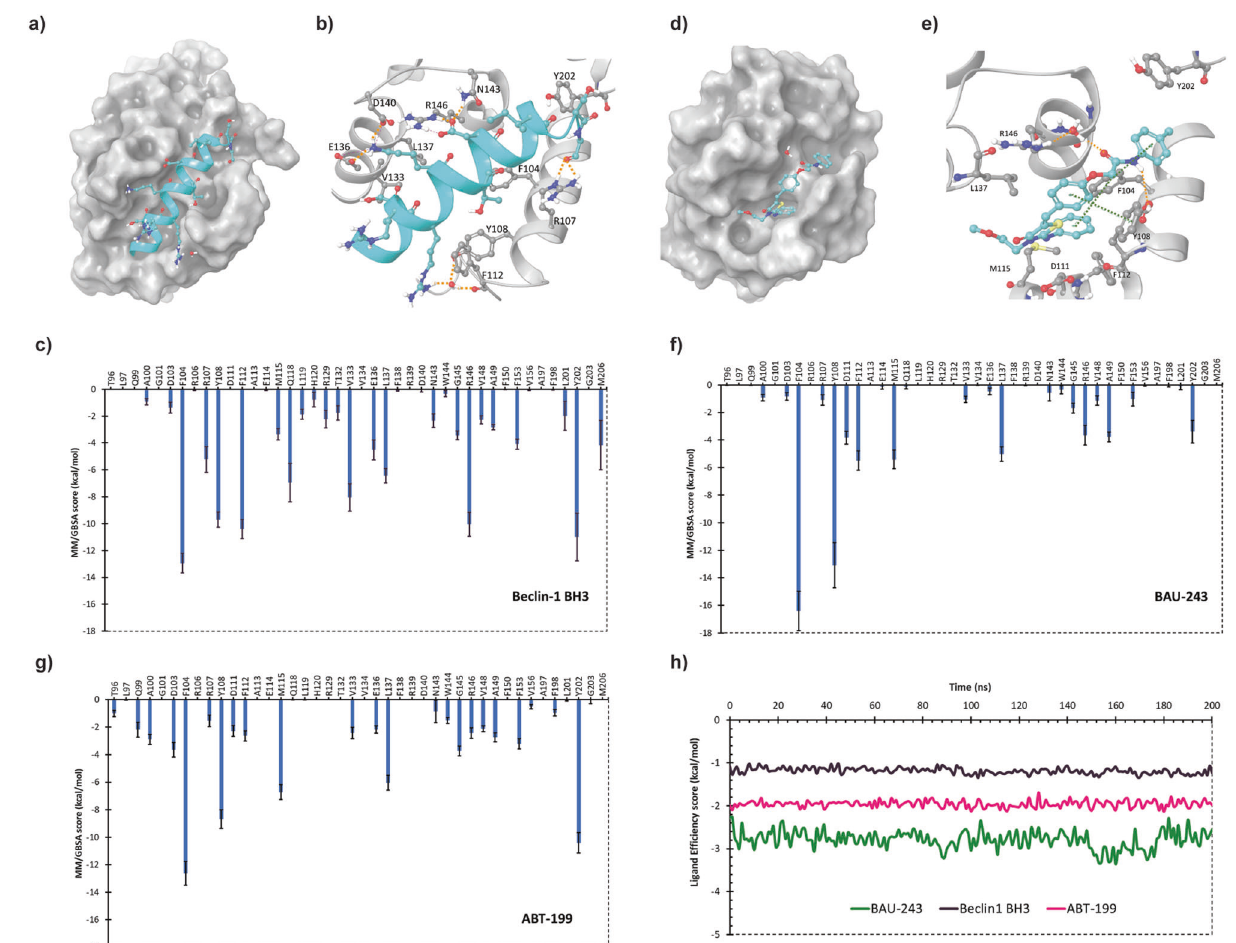
Fig. 6 BAU-243 interacted with BH3 binding domain of Bcl-2 protein. a Bcl-2 in complex with Beclin 1 BH3 domain with Bcl-2 represented as gray colored surface. Water molecules and residues of Beclin 1 BH3 are displayed with the ball and stick representation with C atoms colored in dark cyan, O atoms in red, N atoms in dark blue, and polar H atoms in white. Orange dashed lines indicate hydrogen bonds. b 3D representation of interactions between Beclin 1 BH3 and Bcl-2 with Bcl-2 residue C atoms represented in gray and other atoms colored as in a. c Bcl-2 residues contribution plot for the estimated free energy of Beclin 1 BH3 and Bcl-2 complex calculated by MM/GBSA approach. d Bcl-2 in complex with BAU-243 with Bcl-2 represented as gray colored. Atoms in the ligand molecule are colored as explained in a. e 3D representation of interactions between BAU-243 and Bcl-2 with Bcl-2 residue C atoms represented in gray and other atoms colored as in ( a ). Orange dashed lines indicate hydrogen bonds while green dashed lines indicate π - π stacking interactions. f Bcl-2 residues contribution plot for the estimated free energy of BAU-243 and Bcl-2 complex calculated by MM/GBSA approach. g Bcl-2 residues contribution plot for the estimated free energy of ABT-199 and Bcl-2 complex calculated by MM/GBSA approach. h Ligand ef fi ciency scores for Beclin 1 BH3, BAU-243, and ABT-199 were estimated throughout MD